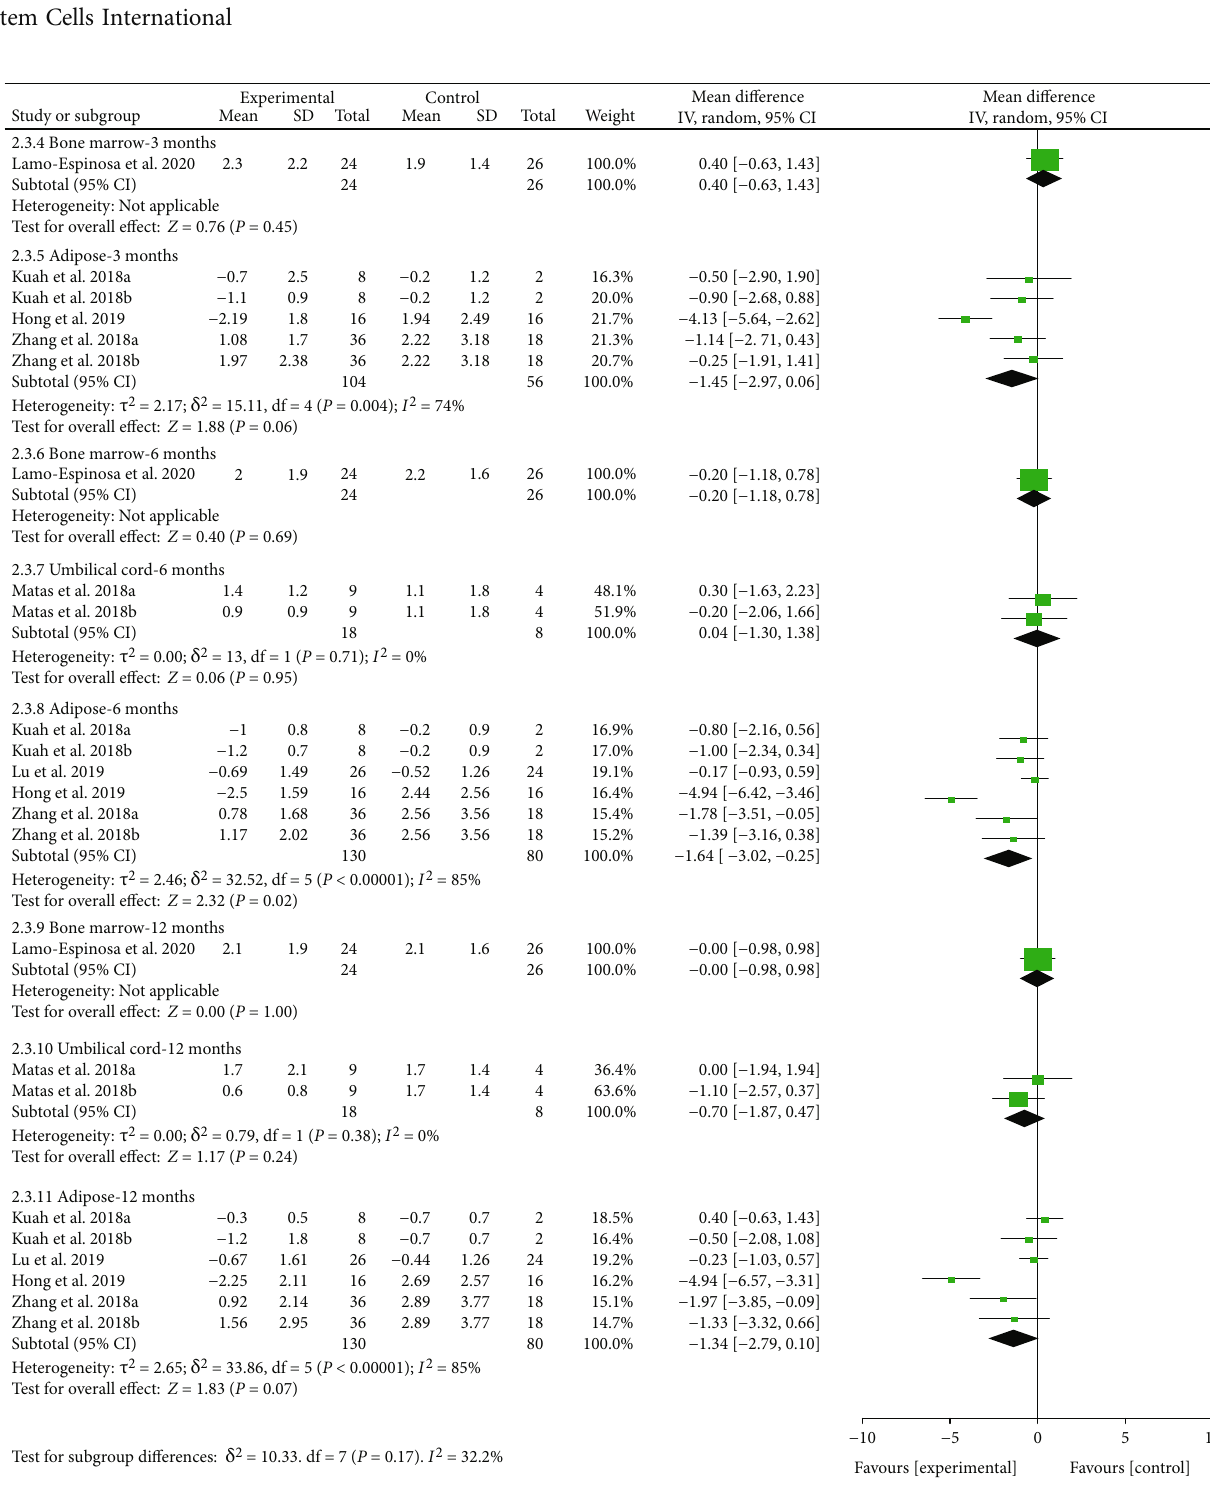
Figure 11: WOMAC sti ff ness-di ff erent cell